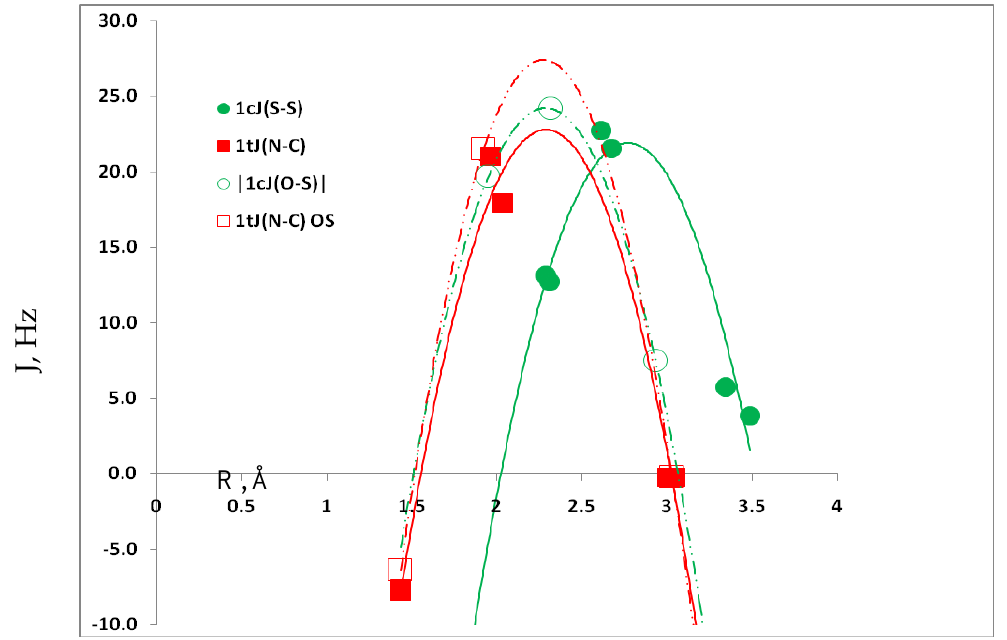
Figure 6. Coupling constants 1c J(S – S) for HN(CH)SF:SCO and HN(CH)SCl:SCO versus the S – S distance, 1c J(O – S) versus the O – S distance for HN(CH)SF:OCS, and 1t J(N – C) versus the N – C distance for corresponding complexes, transition structures, and molecules. Solid symbols refer to HN(CH)SF:SCO and HN(CH)SCl:SCO, and open symbols refer to HN(CH)SF:OCS. 3.5. Comparison of C s Complexes, Molecules, and Transition Structures HN(CH)SX:SCO and HN(CH)SX:OCS